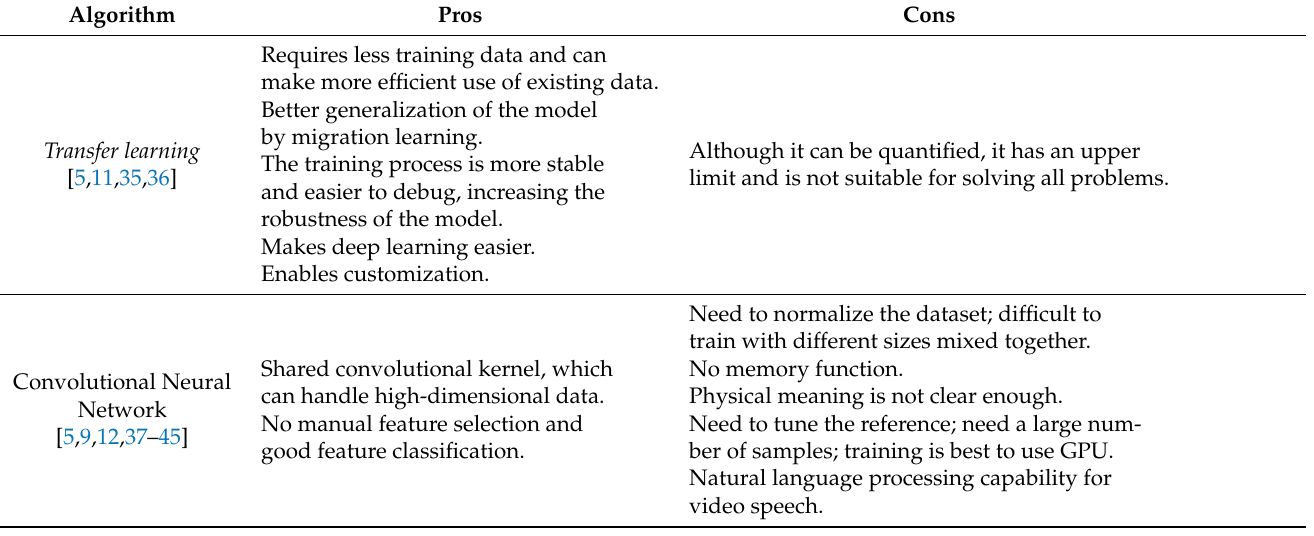
Table 5. Intelligent mineral identification methods based on Transfer learning and convolutional neural networks.